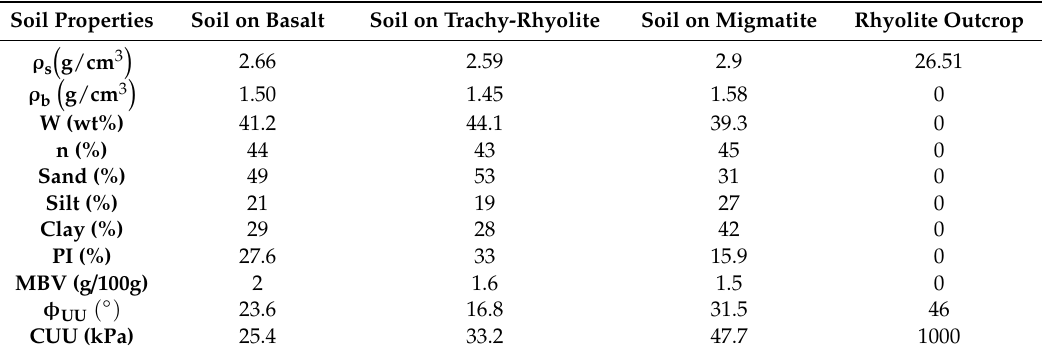
Table 4. Average soil geomechanical values with the corresponding soil types. Soil